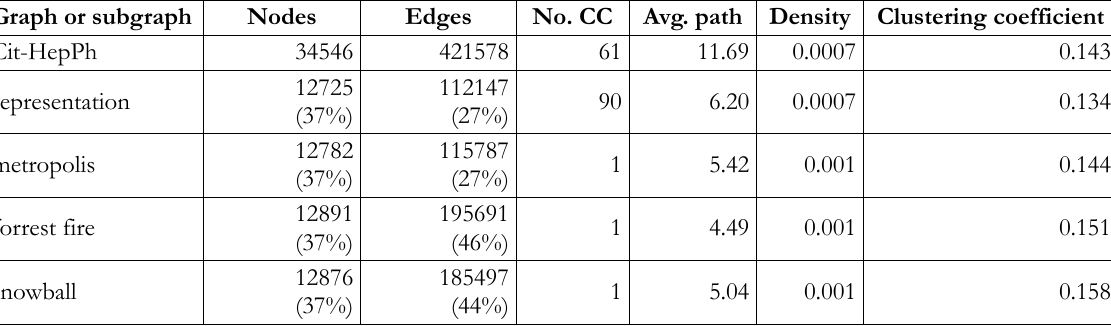
Table 1. Characteristics of original graph and its sampled